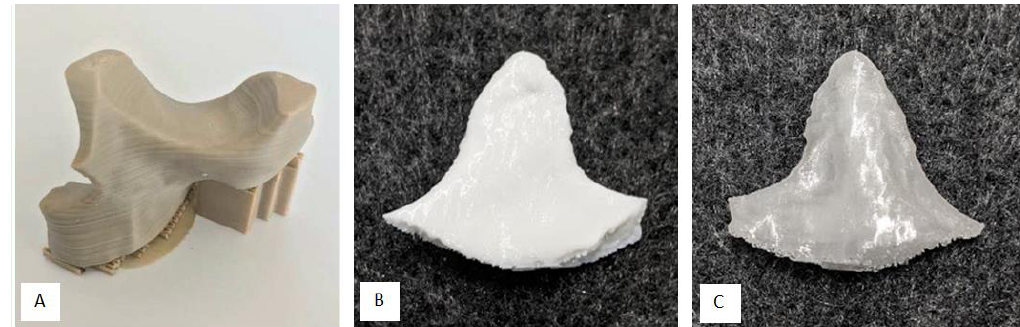
Figure 8. A: Lightweight midface-zygomatic bone patient-specific implant (PSI) with support structures for immediate replacement [30]; B: muscular process (left side of the mandible, exterior) PSI (performance implant B); C: muscular process (left side of the mandible, interior) PSI